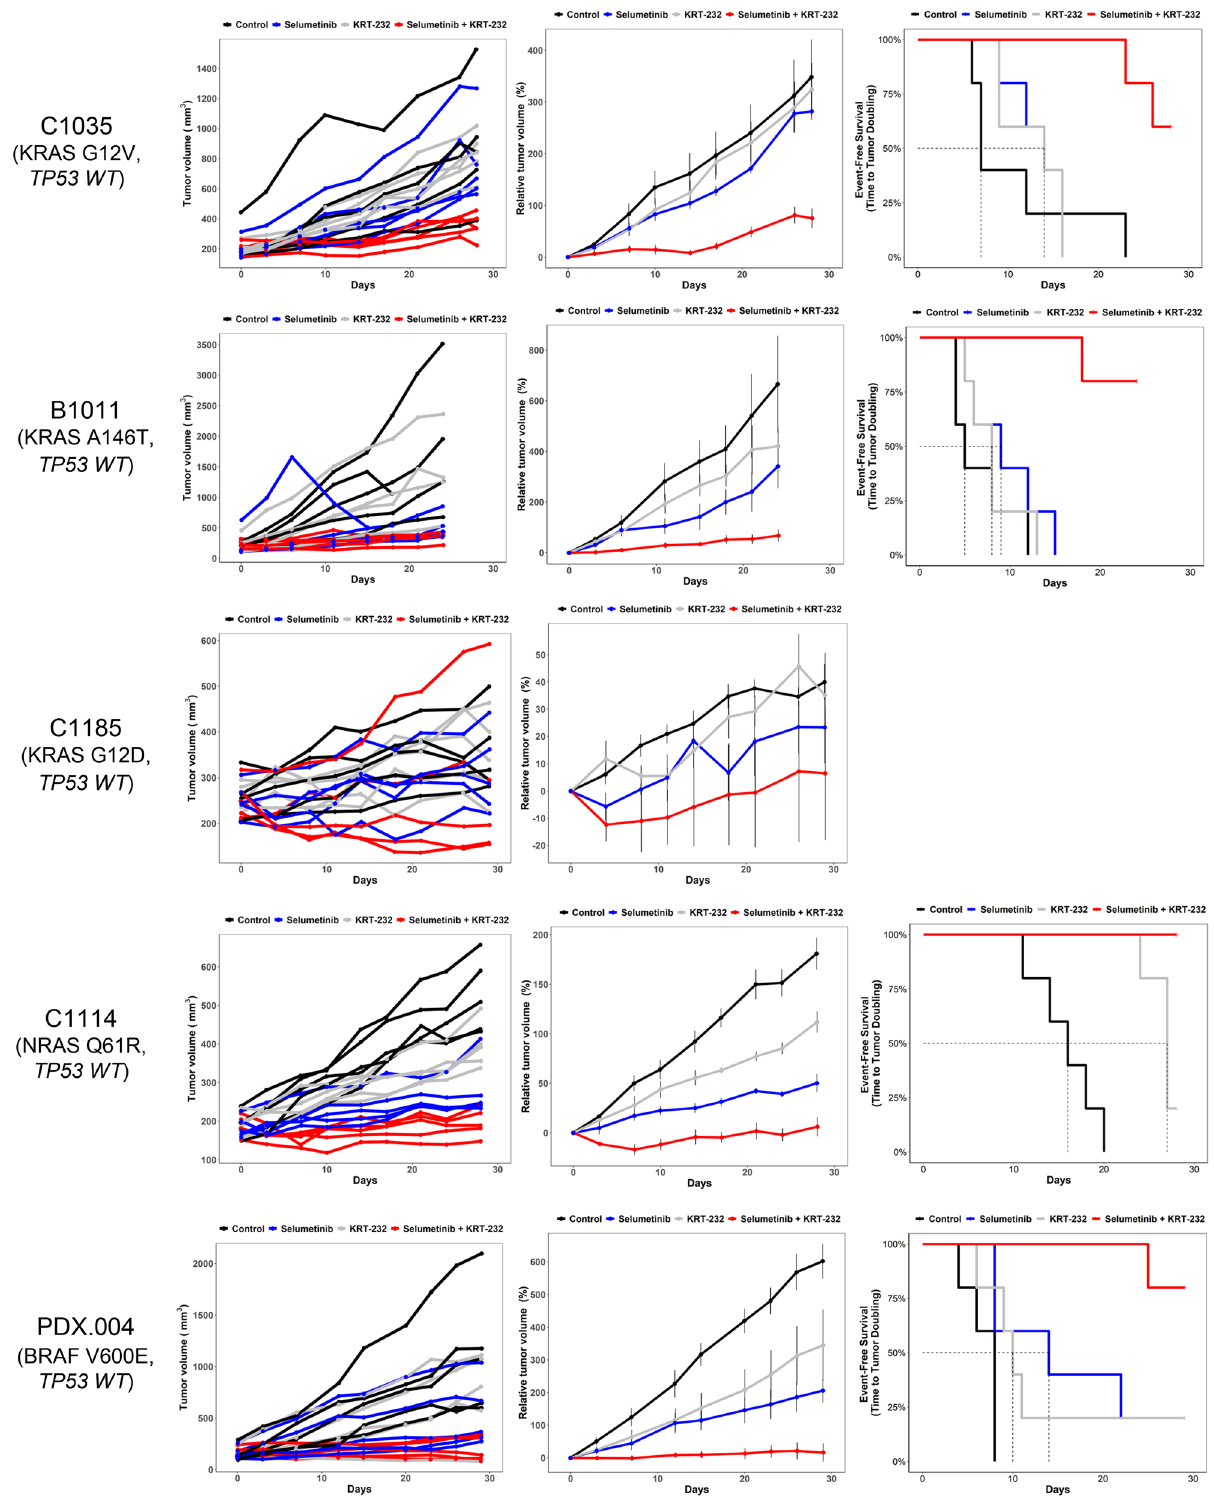
Figure 3. Selumetinib combined with KRT-232 inhibits tumor growth in CRC PDX models. Female athymic nu/nu mice bearing C1035 PDXs were treated with vehicle, selumetinib 15 mg/kg, KRT-232 15 mg/kg or the combination of both. The other four PDX were treated with vehicle, selumetinib 25 mg/kg, KRT-232 15 mg/kg or the combination of both. Selumetinib and KRT-232 were both administered daily. The treatment was stopped at 28 days or when tumor diameter reached 1.5 cm. Left panel, individual tumor volume change (mm 3 ). Middle panel, growth curve graphs demonstrating mean change in tumor volume percentage ± SEM. Right panel, event- free survival curves. The C1185 model did not have any events and is not shown